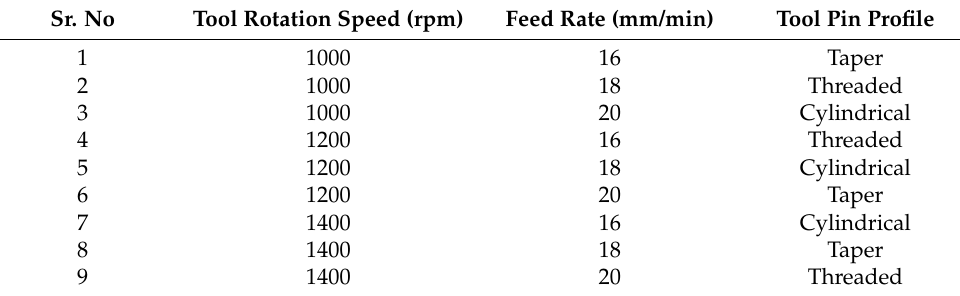
Table 3. Input variables or L 9 orthogonal array.